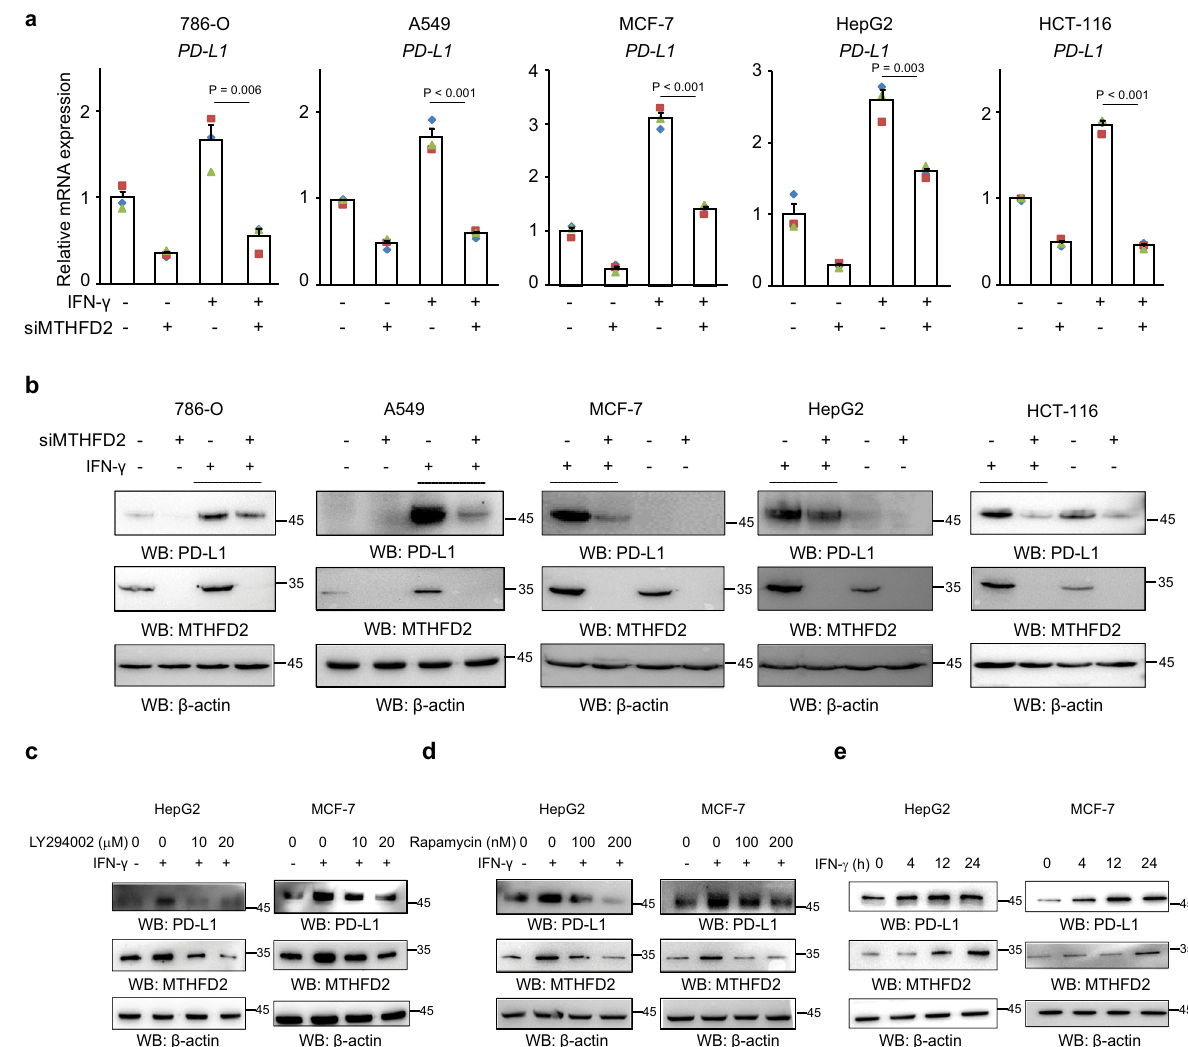
Fig. 3 MTHFD2 is induced by IFN- γ and involved in IFN- γ -mediated PD-L1 regulation. a , b Indicated cancer cells transfected with control or MTHFD2 siRNAs for 24h and then treated with 0 or 20 ng/ml IFN- γ for another 24 h, PD-L1 mRNA levels were analyzed by real-time PCR ( a ) and immunoblotting analyses were performed using the indicated antibodies ( b ). c , d Indicated cancer cells pretreated with LY294002 ( c ) and Rapamycin ( d ) with indicated concentrations and then cultured with 20 ng/ml IFN- γ , immunoblotting analyses were performed using the indicated antibodies. e Indicated cancer cells treated with 20 ng/ml IFN- γ for indicated times, immunoblotting analyses were performed using the indicated antibodies. In ( a ), the values are presented as mean ± s.e.m ( n = 3 independent experiments); p values (Student ’ s t test, two-sided) with control or the indicated groups are presented (also see Supplementary Fig. (Fig. 6e, lower) while MTHFD2-KD decreased the total cMYC protein (input) (Fig. 6f, lower), but affected cMYC-T58A